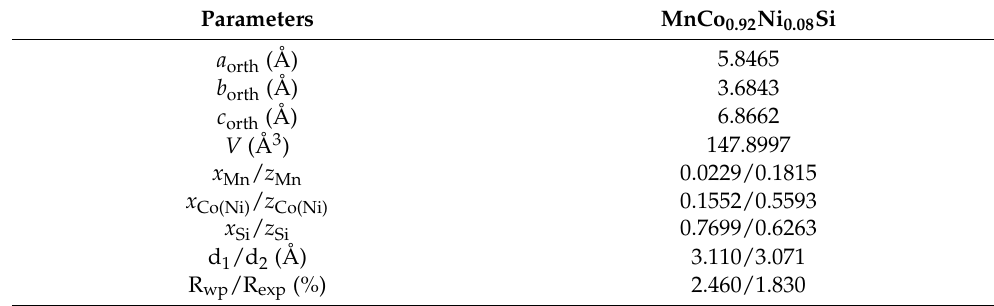
Figure 1. ( a ) Measured (in black circles) and calculated (in red line) powder X-ray diffraction patterns at room temperature for MnCo 0.92 Ni 0.08 Si alloy. The reliability factors (R wp and R exp ) are indicated in the figure. ( b ) The crystal structure of Hexagonal and Orthorhombic. ( c ) Pole figures of the MnCo 0.92 Ni 0.08 Si alloy were measured by XRD. The inset in ( c ) illustrates the schematic diagram of the specimen. ( d ) Microstructure and ( e ) Orientation Map for the MnCo 0.92 Ni 0.08 Si alloy. ( f ) Inverse pole figure corresponding to Y is calculated according to the EBSD measurements. Table 1. Experimental details and refined crystallographic data for the MnCo 0.92 Ni 0.08 Si alloy.